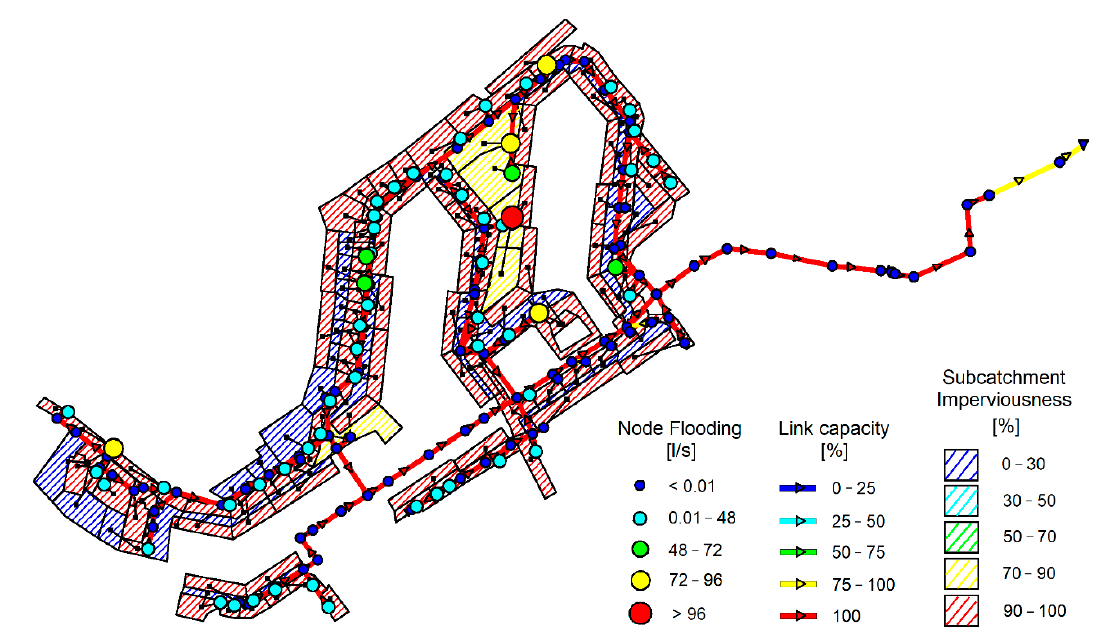
Figure 5. A visual illustration of the flood event in the SWMM (05/27/2017 14:07).